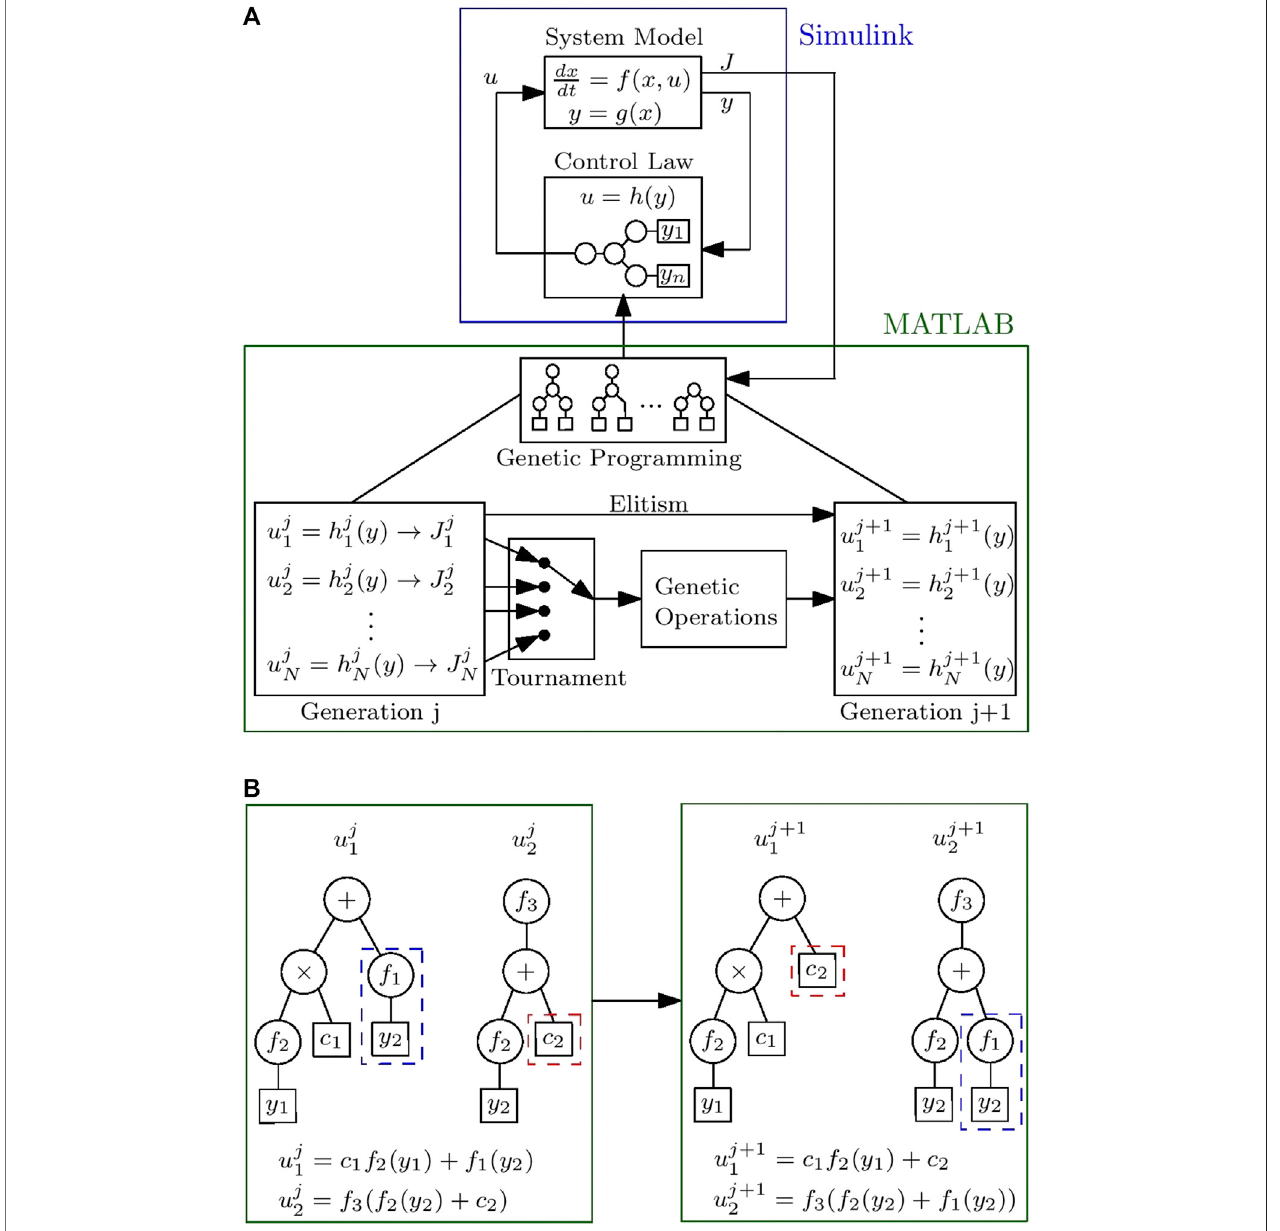
FIGURE 3 | Application of GP in control systems (Duriez et al., 2017). A general overview of the implementation is shown in (A) , while an example of the crossover operation is shown in (B) . The terminals are enclosed by squares while functions are in circles.